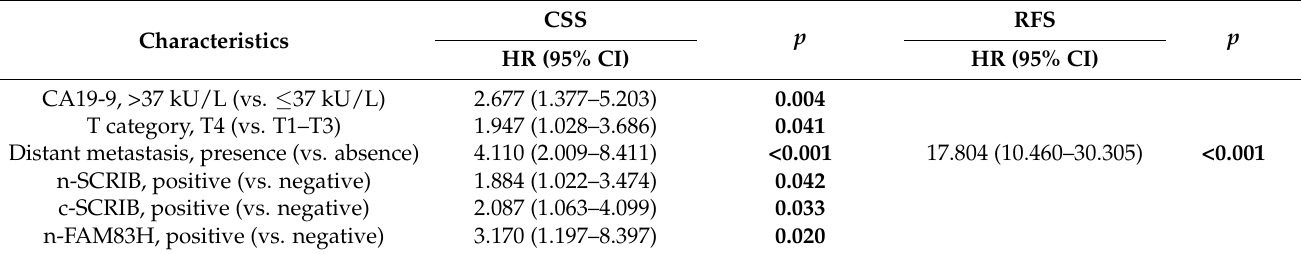
Table 3. Multivariate Cox regression analysis for cancer-specific survival and relapse-free